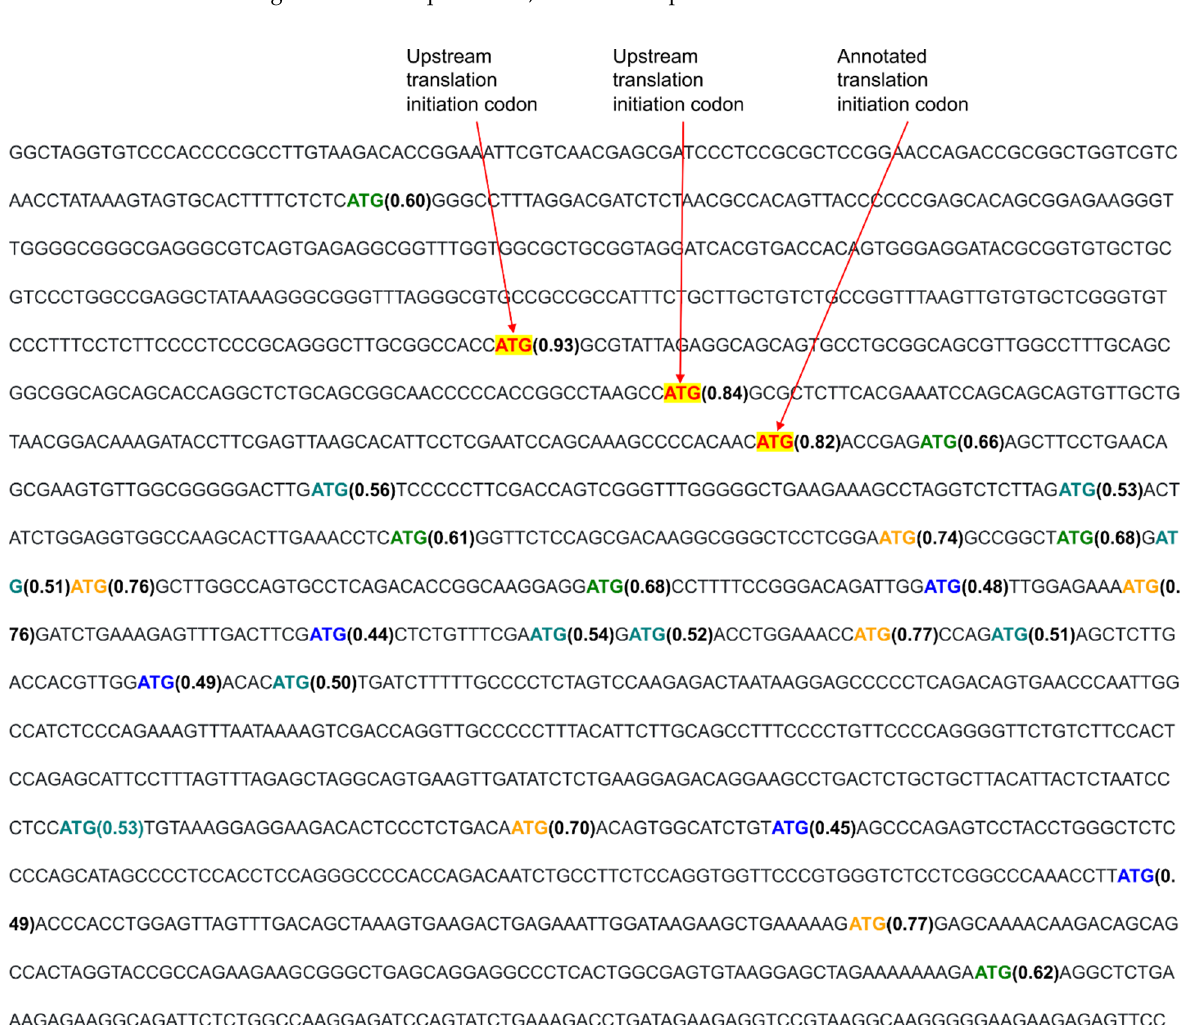
Figure 6. 5 ′ UTR of MAPKAPK2 transcript with near-cognate and ATG codons color-coded. In this figure and subsequent ones, the KSS is in parentheses after the codon.